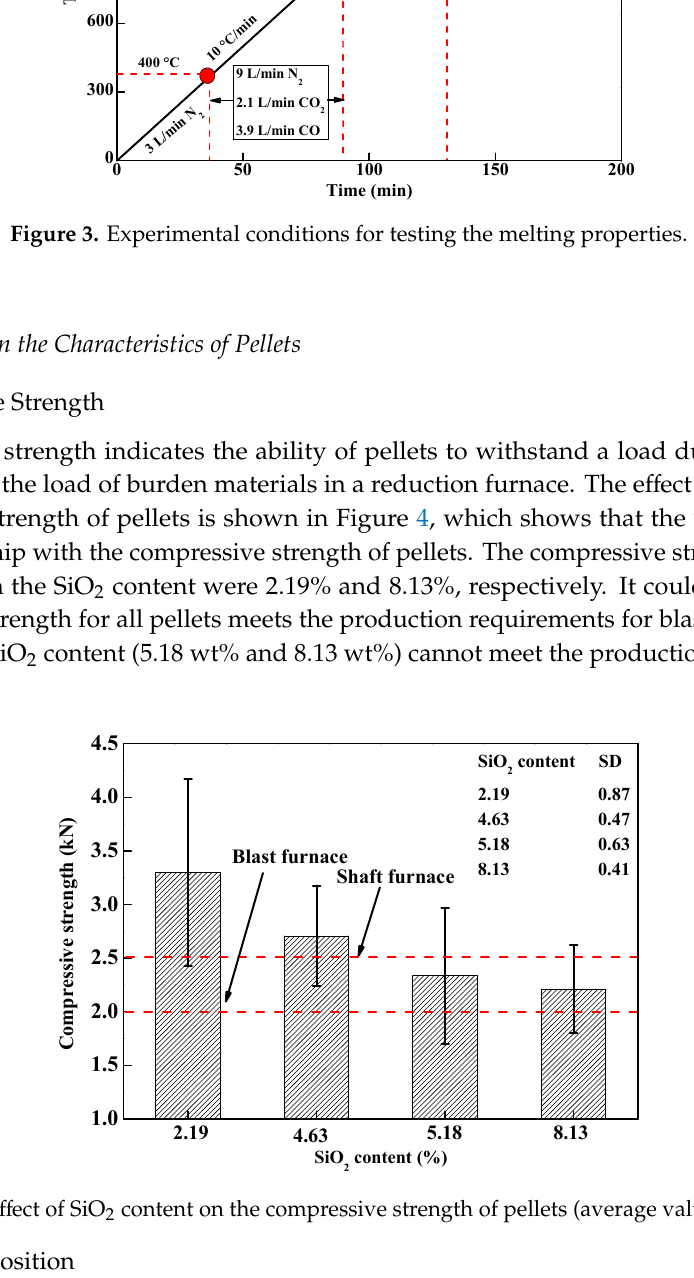
Figure 4. The effect of SiO 2 content on the compressive strength of pellets (average value of ten times).